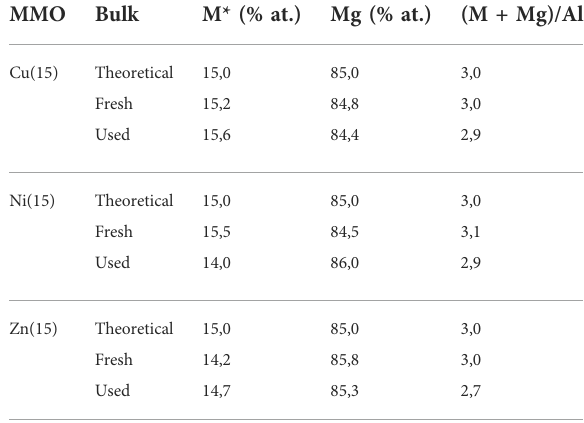
FIGURE 7 TPD-CO 2 pro fi les of OMM samples.